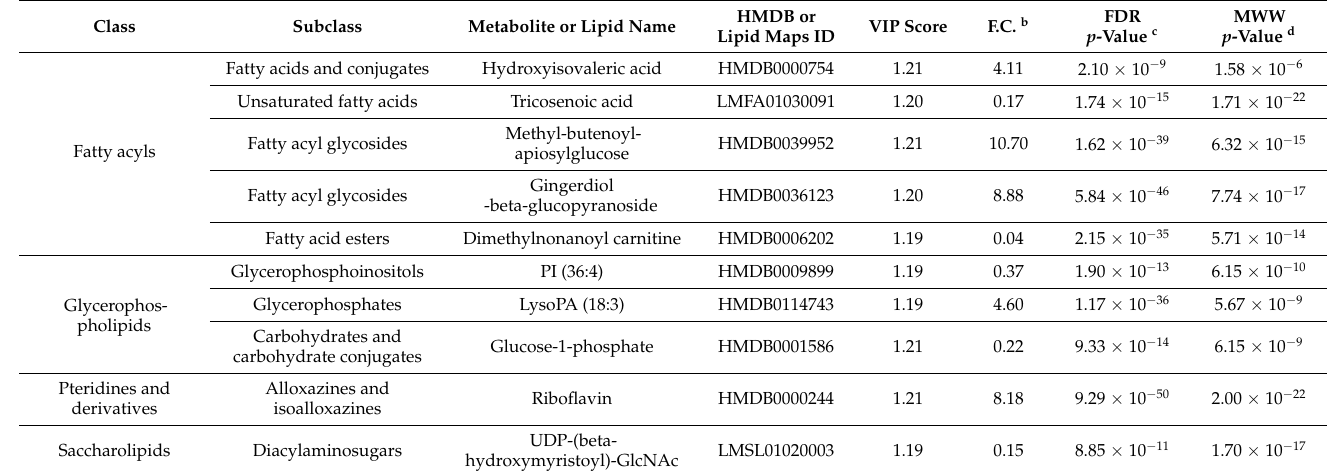
Table 1. Top altered metabolites identified from the integrated metabolomics and lipidomics data set a